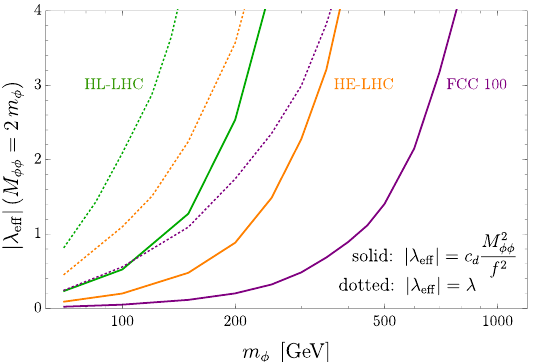
Figure 8: Hadron collider sensitivity on the effective coupling evaluated at the thresh- old M φφ = 2 m φ , for the derivative and marginal portals, as obtained from our anal- ysis. The figure quantifies the sensitivity gain that follows from the relative scaling ∝ ˆ s 2 in Eq.